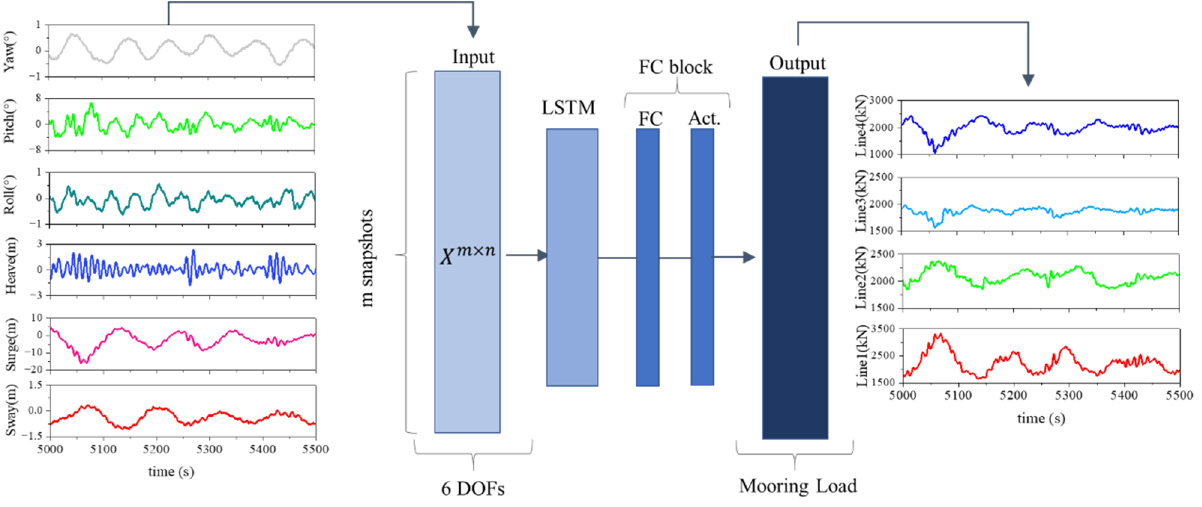
Figure 2. Illustration of the LSTM-based mooring load prediction